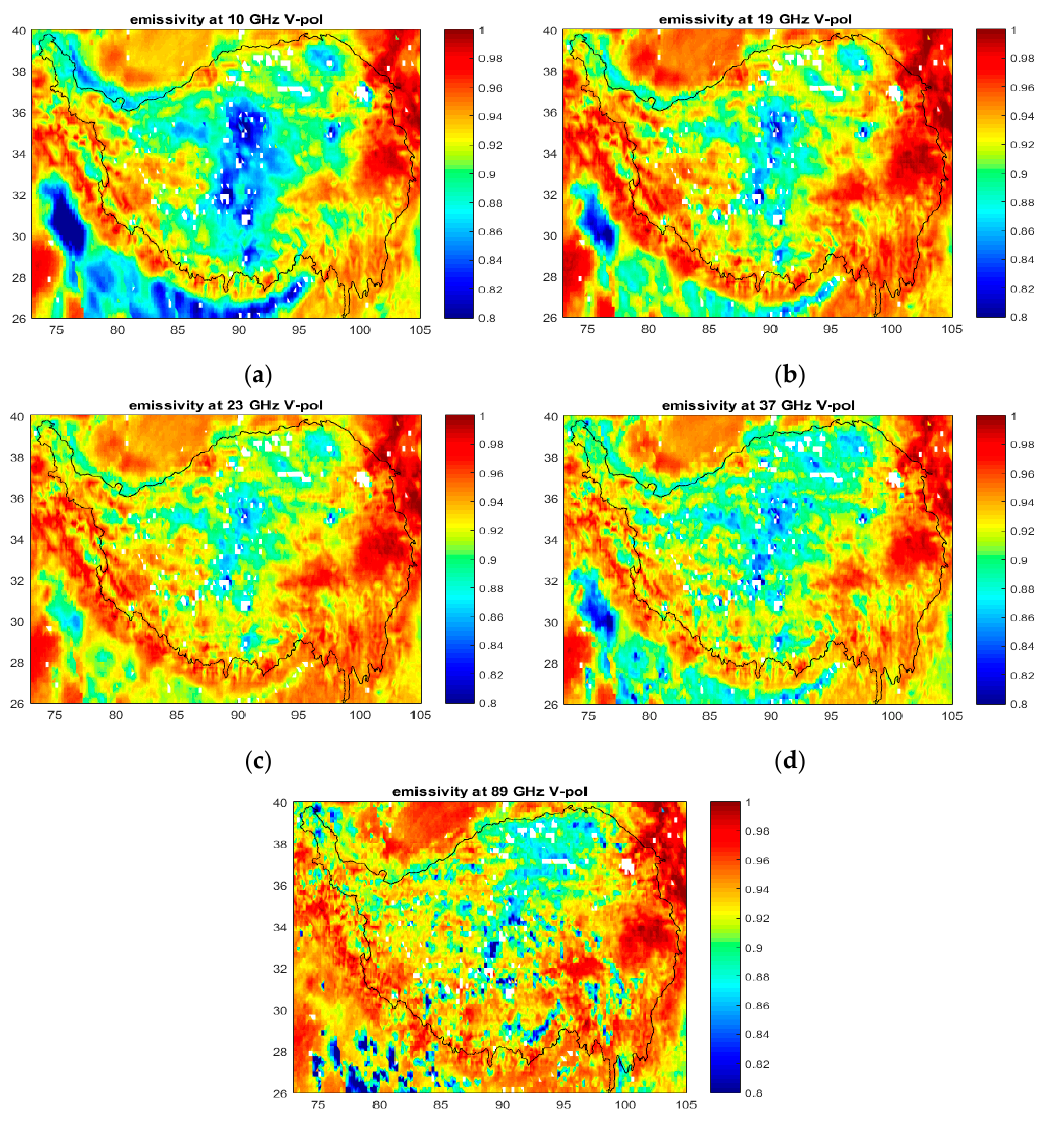
Figure 4. Land surface emissivity at 10, 19, 23, 36 and 89 GHz for vertical polarization: ( a ) 10 GHz; ( b ) 19 GHz; ( c ) 23 GHz; ( d ) 36 GHz; and ( e ) 89 GHz.